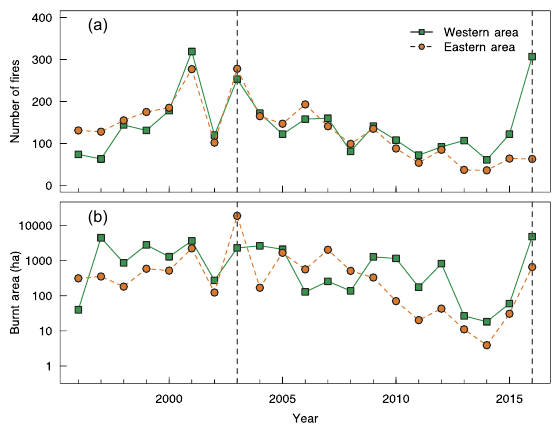
Figure 3. Interannual variations in (a) number of fires and (b) burnt areas for the two studied areas. Dotted vertical lines indicate the 2003 and 2016